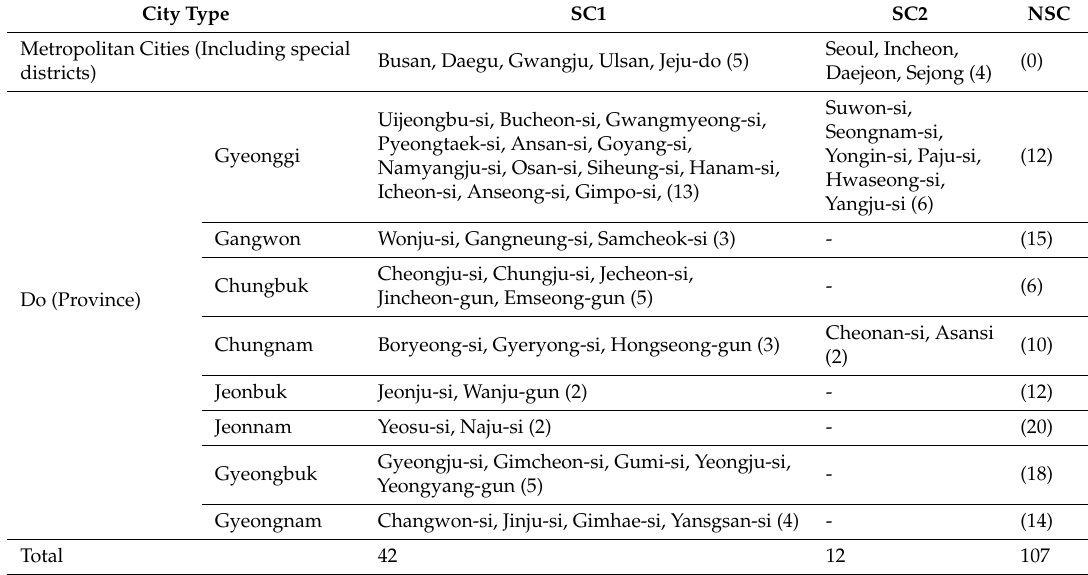
Table 5. Categorization of